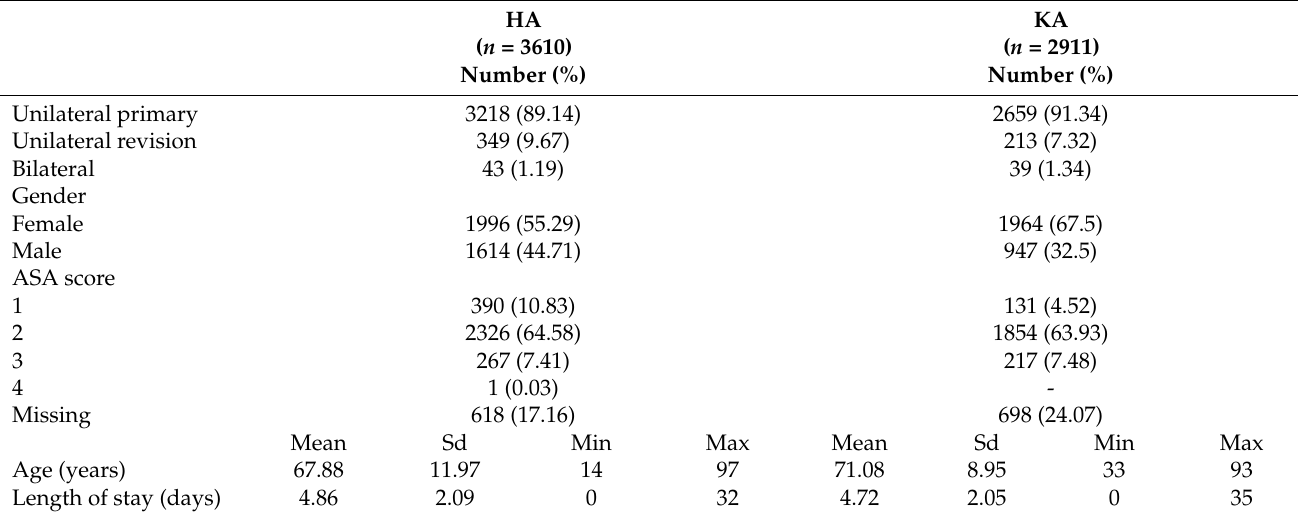
Table 3. Descriptive statistics.